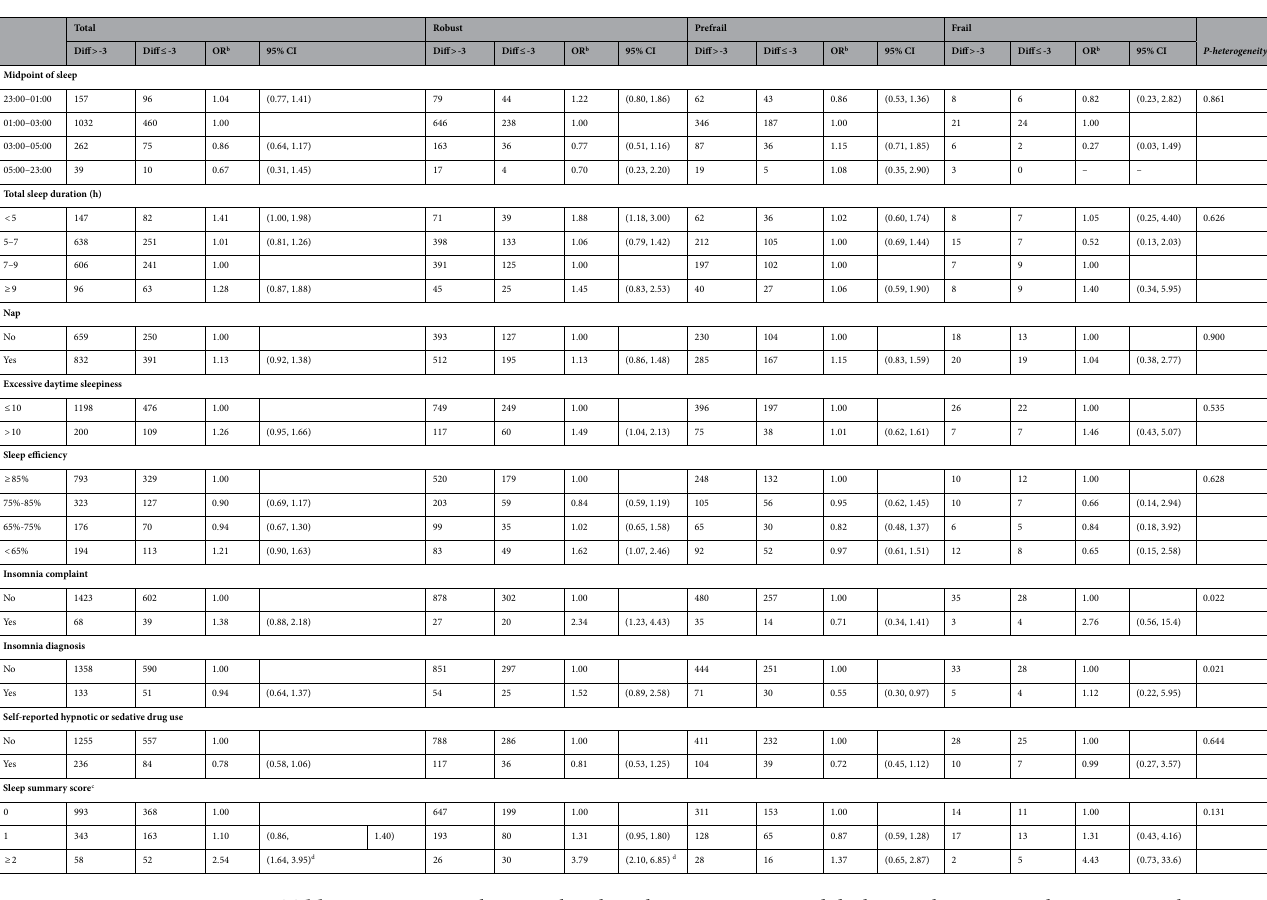
Table 3. Association between baseline sleep parameters and decline in the score on the Min-Mental Status Examination a based on physical frailty status. CES-D center for epidemiologic studies–depression scale, CI confidence interval, h hours, OR odds ratio, NE not estimable. a A substantial decline in score was defined as a drop of 3 or more points at the follow-up assessment. b Odds ratios were adjusted for age at the baseline assessment, sex, center, education, current working status, betel nut chewing status, number of chronic diseases, social network score, and CES-D score (and physical frailty status for total). c Sleep summary score was created for having short or long sleep duration (< 5 or ≥ 9 h), excessive daytime sleepiness, and insomnia complaints. d P < 0.005.